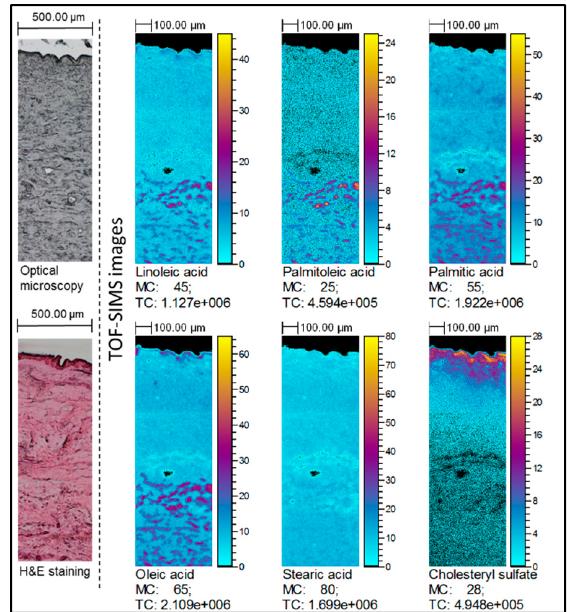
Figure 3. TOF-SIMS images of the skin treated with olive oil: spatial localization of selected ions compared to the optical image. TOF-SIMS images (negative ion mode) showing lateral distribution of palmitoleic, palmitic, linoleic, oleic and stearic acid ions in the skin. Field of view was 1.5 × 0.5 mm 2 , 750 × 250 pixels, pixel size 2 × 2 µ m 2 , fluence 5 × 10 11 ions/cm 2 . The amplitude of the color scale corresponds to the maximum number of counts MC and could be read as [0, MC]. TC is the total number of counts recorded for the specified m / z (the sum of counts in all pixels).